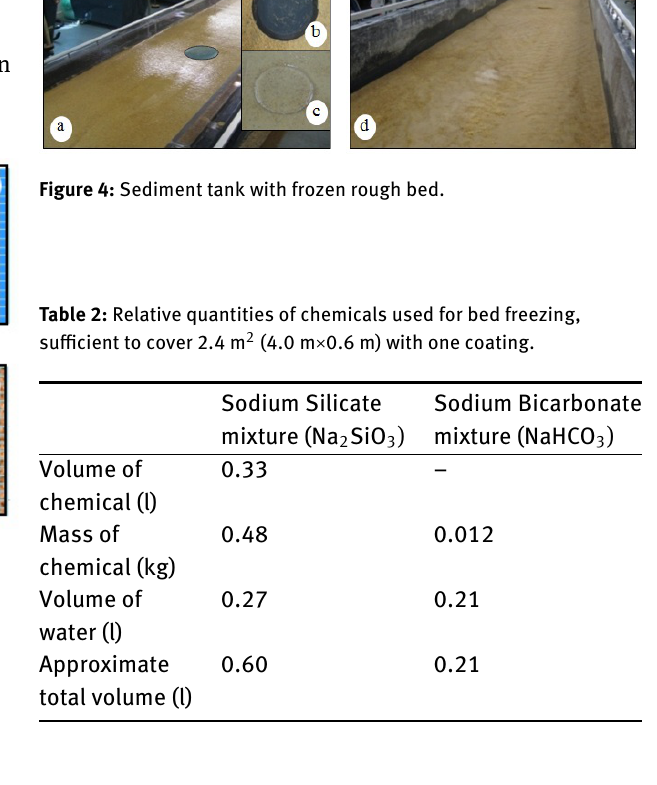
Figure 2: Modified UEL Ahlborn sediment bed tank and Soil Protru- sion Apparatus (SPA) for smooth bed conditions.